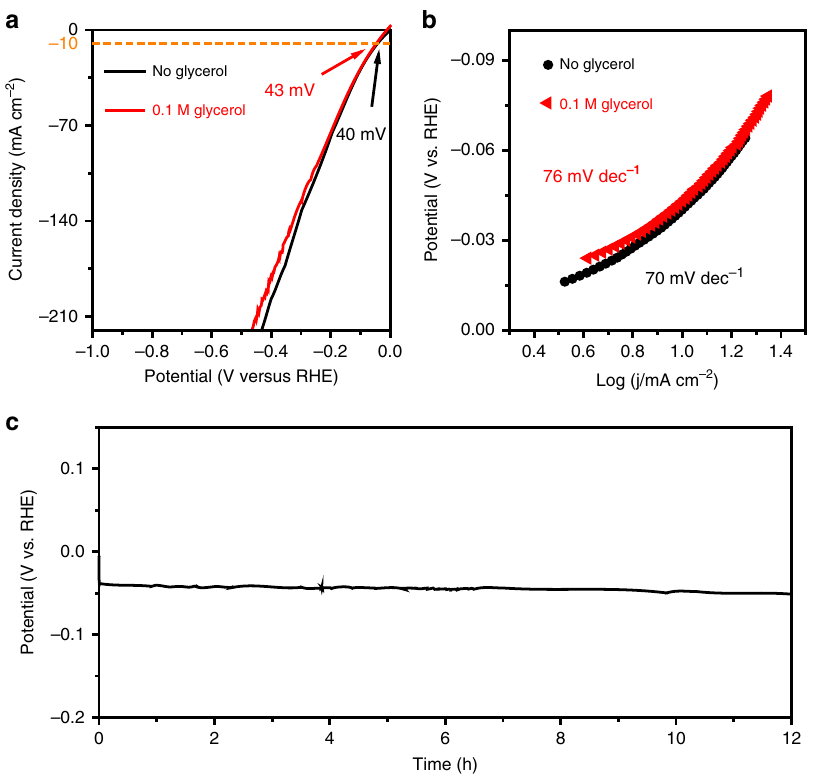
Fig. 5 Electrocatalytic performances of Ni – Mo – N/CFC in HER at the cathod. a LSV curves for the HER of Ni – Mo – N/CFC in 1.0 M KOH with and without 0.1 M glycerol addition. Scan rate, 2 mV s − 1 . b Tafel plots for the HER derived from ( a ). c Twelve hour stability test of Ni – Mo – N/CFC for cathodic HER at a current density of 10 mA cm − 2